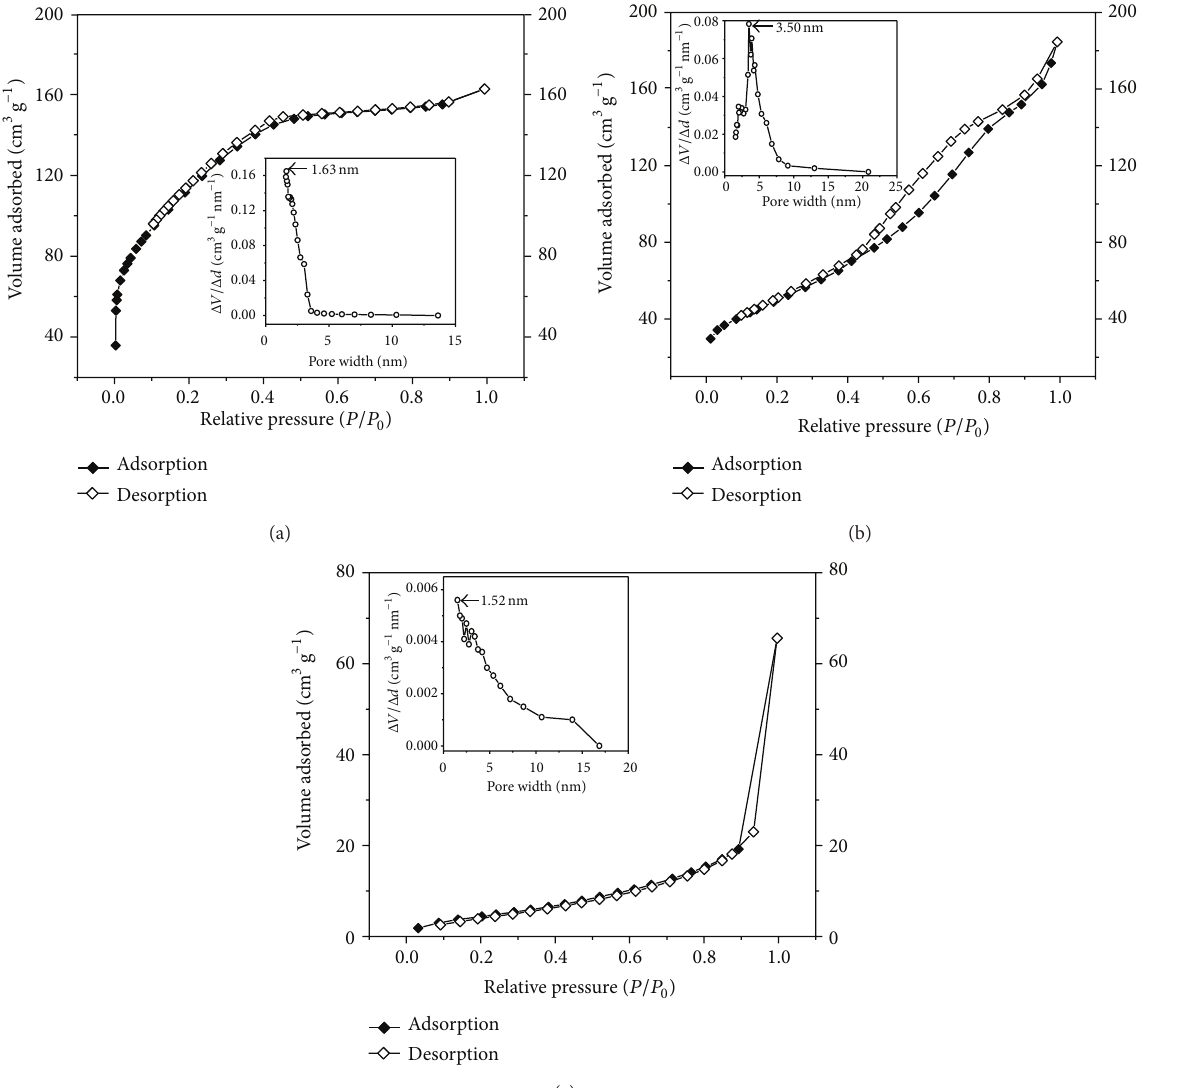
Figure 5: Nitrogen adsorption-desorption isotherms and pore size distribution curve (inset) of (a) Ta, (b) Tb, and (c) LTO700.